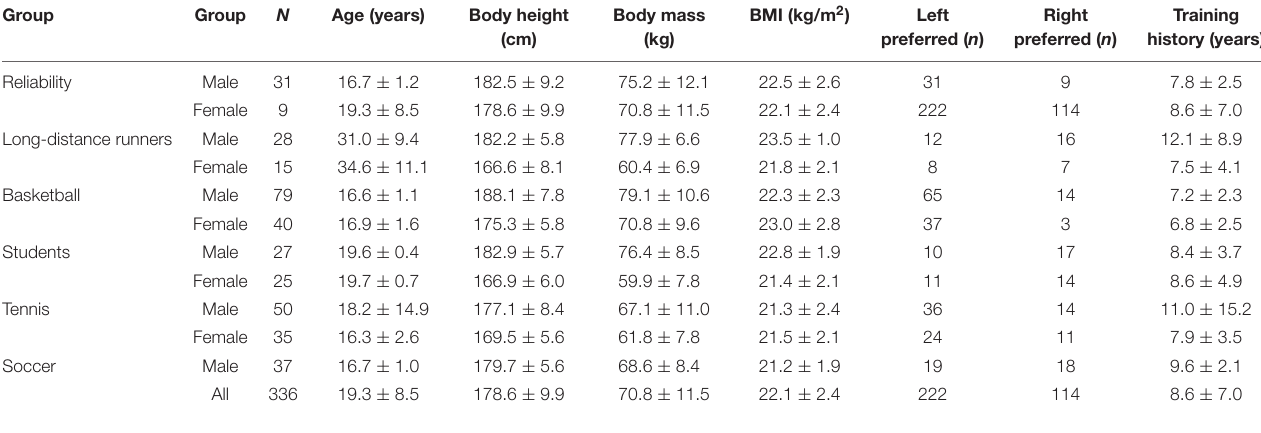
TABLE 1 | Characteristics of the